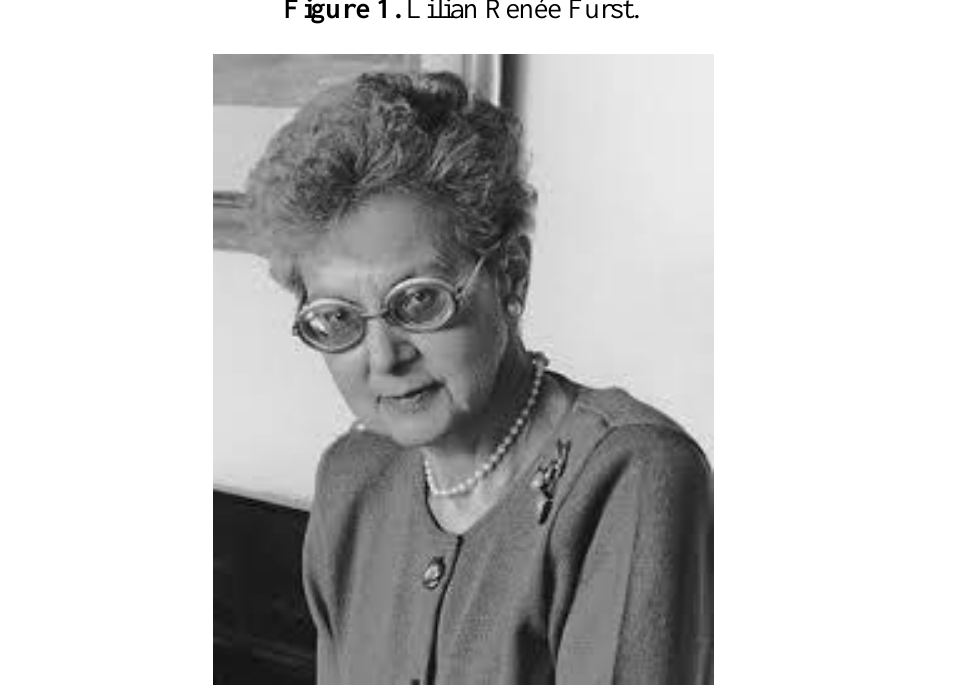
Figure 1. Lilian Renée